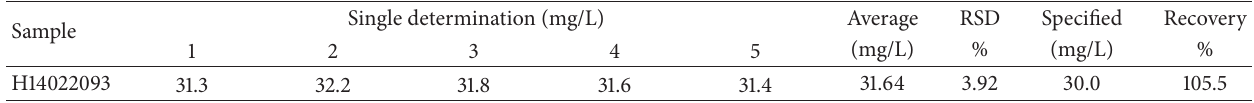
Table 3: Analysis results of protionamide content in protionamide